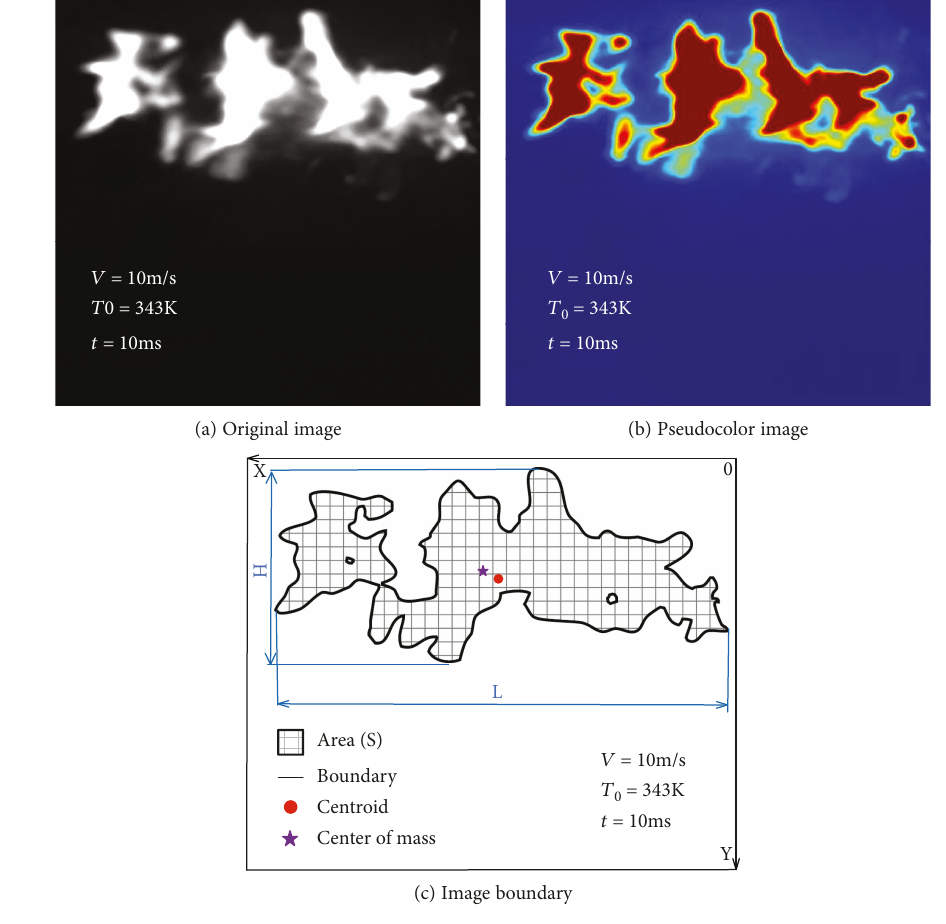
Figure 4: Image processing method.